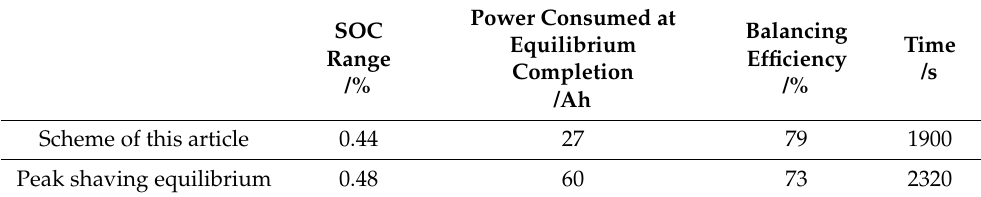
Table 4. Equilibrium result of charging state .